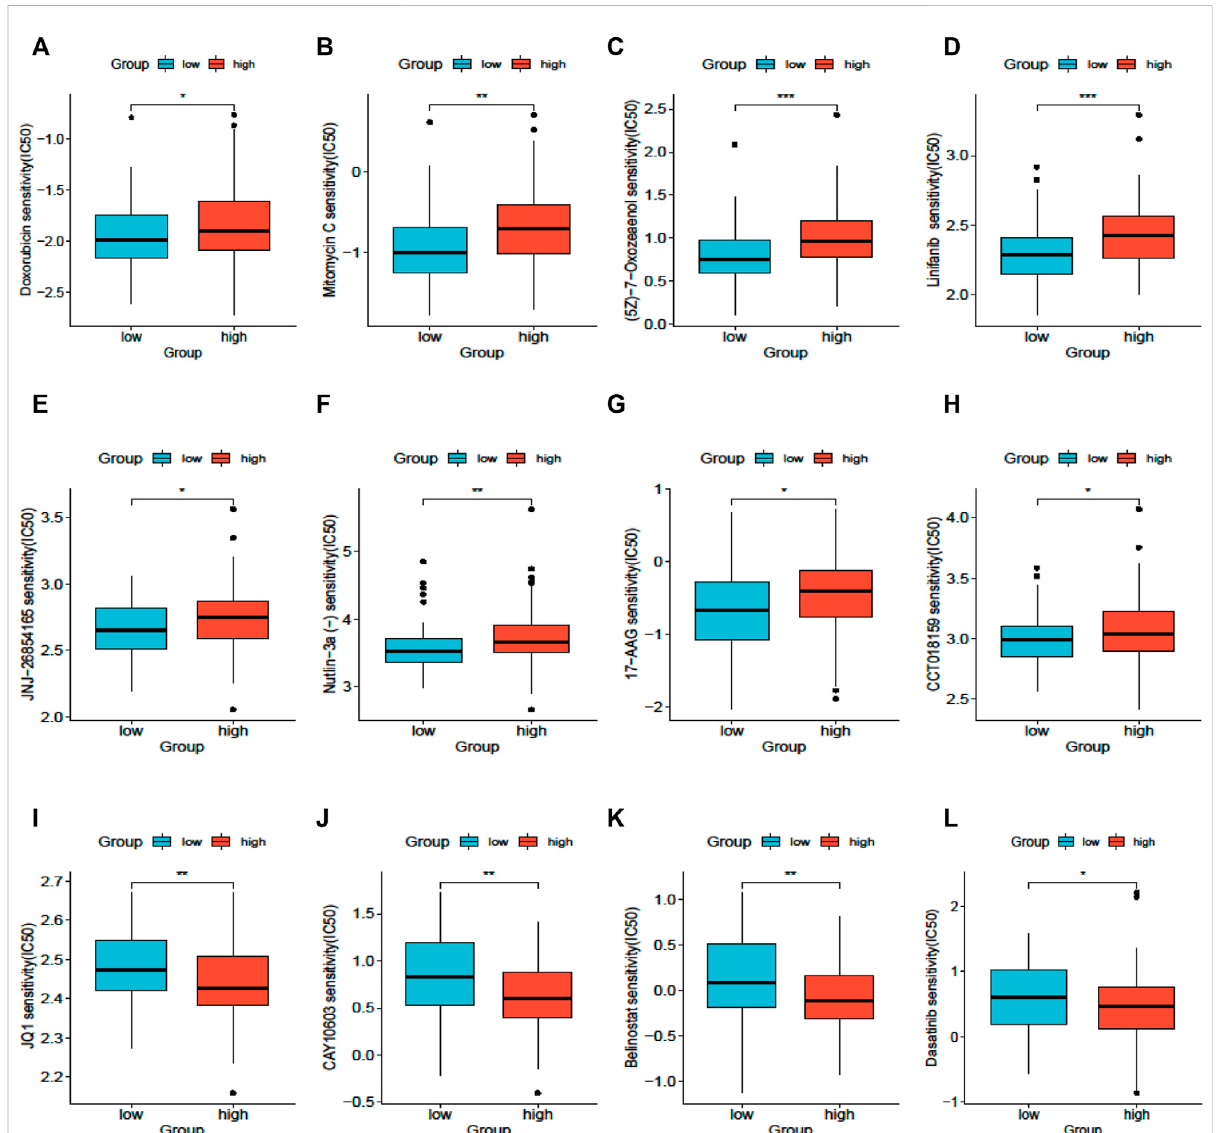
FIGURE 7 Drug sensitivity analysis based on SLC25A21. (A) , Doxorubicin. (B) , Mitomycin (C) , 7-Oxozeaenol. (D) , Linifanib. (E) , JNJ-26854,165. (F) , Niutlin- 3a. (G) , 17-AAG. (H) , CCT018159. (I) , JQ1. (J) , CAY10603. (K) , Belinostat. (L) ,